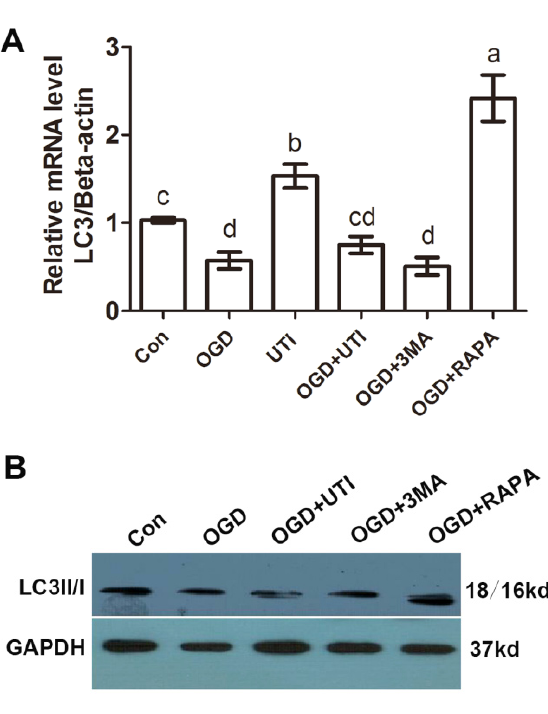
Figure 4: UTI regulated macrophage autophagy. A: Relative mRNA expression of LC3 in macrophages. B: Western blotting analysis of LC3 II/I protein expression levels in macrophages.OGD: Oxygen glucose deprivation; UTI: Ulinastatin; 3MA: 3-Methyladenine; RAPA: Rapamycin. Bars with different letters are significantly different (p <